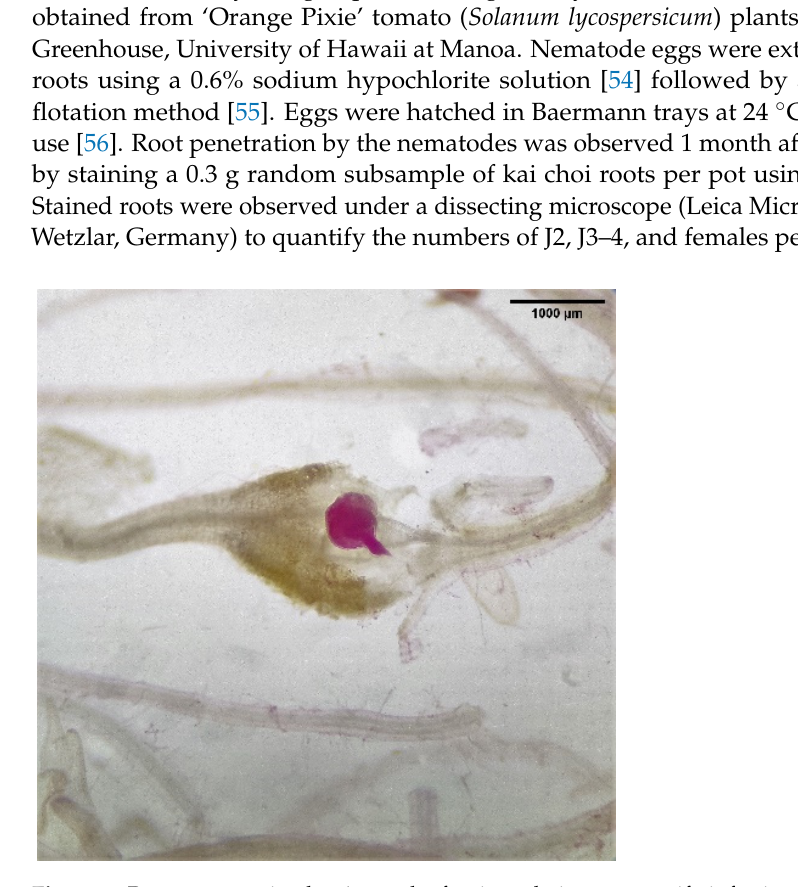
Figure 1. Roots were stained at 1 month after inoculation to quantify infection rates of female